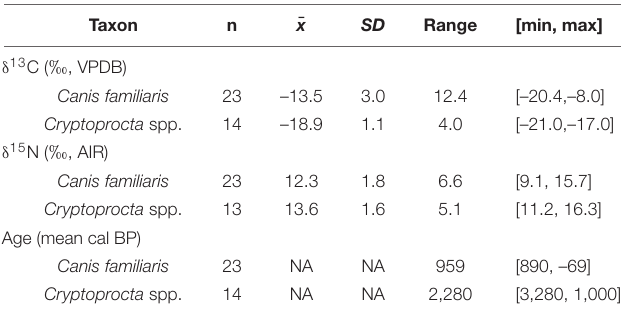
TABLE 1 | Descriptive statistics for island-wide Canis familiaris and Cryptoprocta spp. δ 13 C, δ 15 N, and age